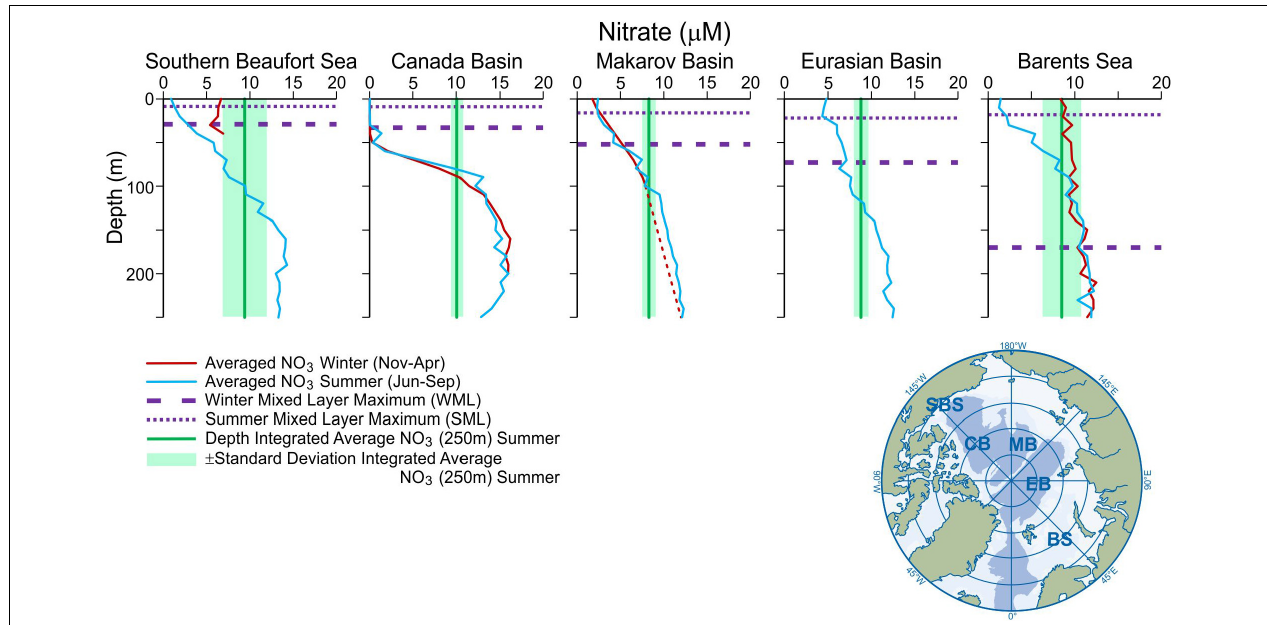
FIGURE 5 | Seasonal mixed layers across the basins. Basin averaged Nitrate (NO 3 , µ M) profiles from “summer” (June-Sept; blue lines) and “winter” (Nov-Apr; red lines) plotted along a transect through the Arctic Ocean from the Southern Beaufort Sea (SBS) to the Barents Sea (BS). Nitrate data were sourced from the Codispoti Arctic Nutrient Atlas (Codispoti et al., 2011), and have been binned over 10 m depth intervals and averaged for their respective seasons, where data were available. Purple dashed lines indicate the average depth of the seasonal mixed layer “summer minimum” (thin line) and “winter maximum” (thick line) after Peralta-Ferriz and Woodgate (2015), green vertical lines ( ± SD) indicate the depth integrated average NO 3 in the upper 250 m from summer